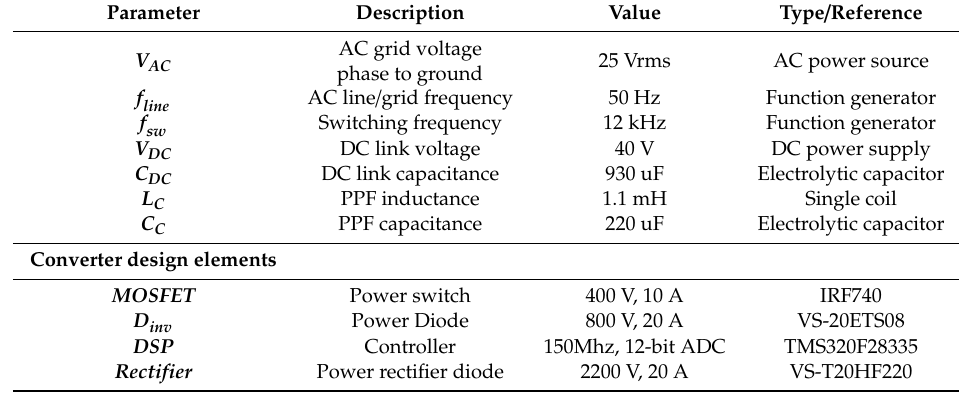
Figure 7. Simulated MG in laboratory. Table 5. Design and system specifications for laboratory tests.